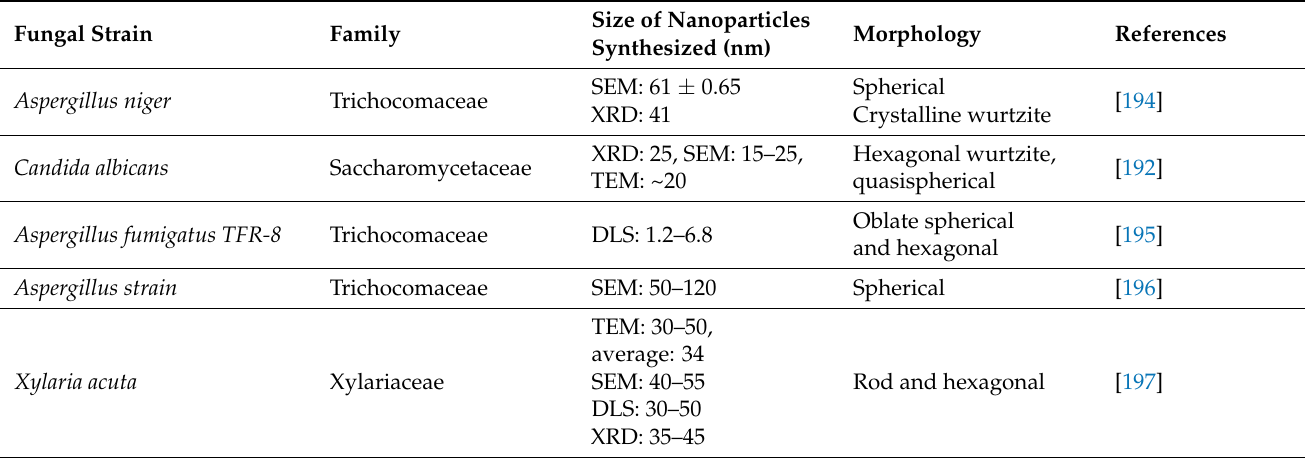
Table 3. Summary of the fungal-mediated synthesis of zinc oxide nanoparticles.